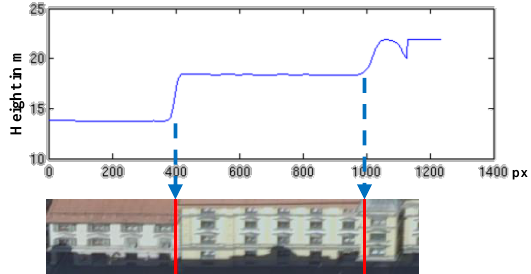
Figure 5. (Top) Height profile of a façade strip. (Bottom) Determined façade splits